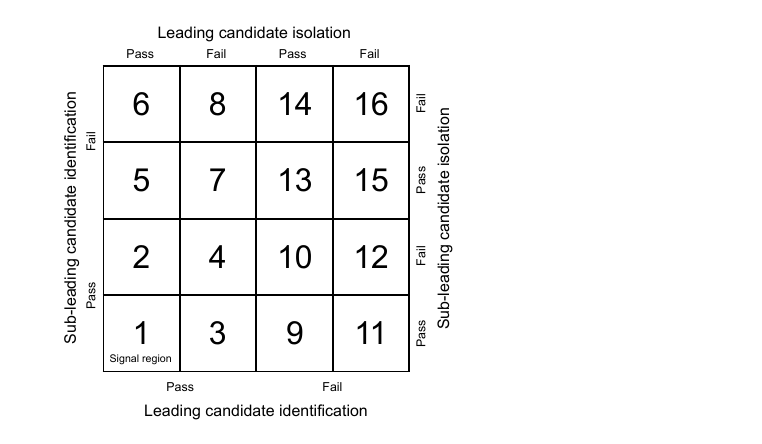
isolation requirement, but falls into 0 . 05 · p , the event < E iso,0.2 < 0 . 15 · p T ,γ 1(2) T ,γ 1(2) T ,γ 1(2) enters in a control region. The isolation signal and control regions are indicated in figure 2, which shows the E iso,0.2 relative isolation distribution for prompt photons and for /p T ,γ 2 T ,γ 2 misidentified